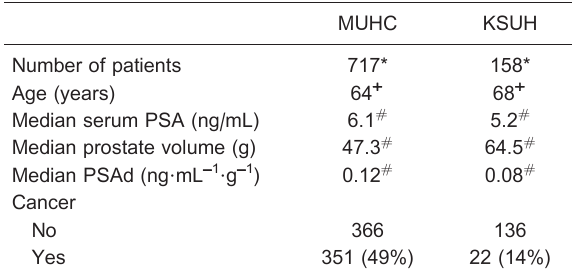
Table 1. Median values for the MUHC and KSUH groups.